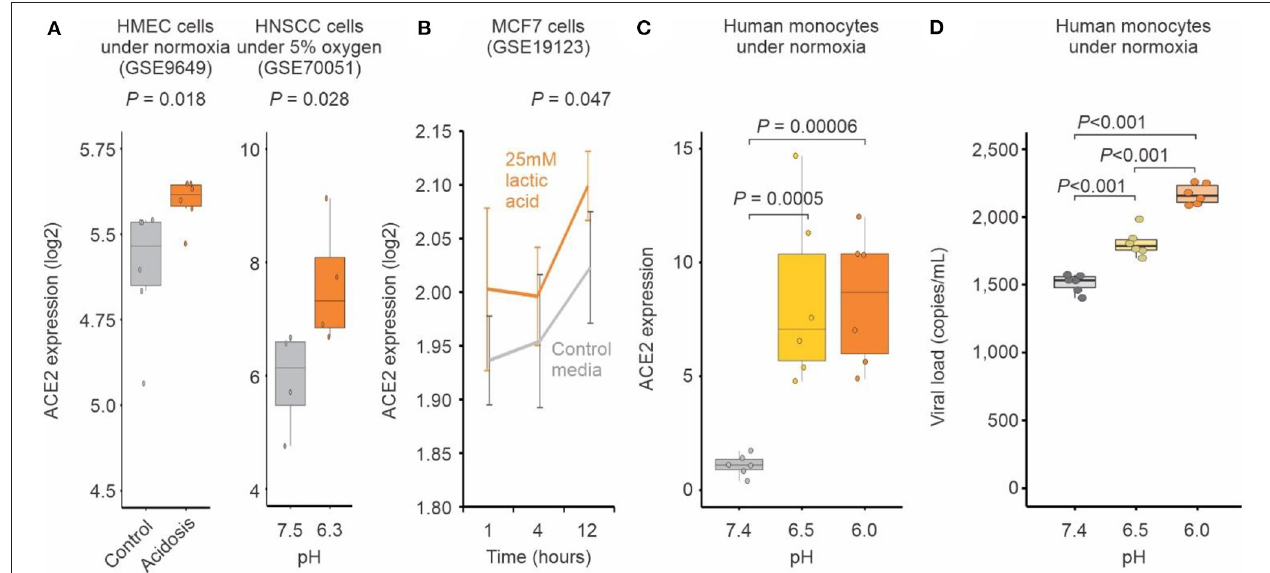
FIGURE 3 | Acidosis increases ACE2 expression and SARS-CoV-2 infection. (A) Human cells exposed to acidosis. Each boxplot represents the log2 expression of samples untreated (gray) or treated with lactic acidosis (brown) for two microarray studies (GSE9649 and GSE70051). Student’s t -test P -values are indicated. (B) MCF7 cells exposed to pH reduction increases ACE2 expression. Gray and brown lines represent, respectively cells treated with control media or with 25mM lactic acid for 1, 4, and 12h (x-axis). Each point represents the mean log2 expression and the error bars the standard deviation of biological replicates. (C) Acid pH increases ACE2 expression in monocytes. Human peripheral blood monocytes were incubated in medium at three different pH (6, 6.5, 7.4) for 24h. Each boxplot represents the fold change ACE2 expression. (D) Acid pH increases SARS-CoV-2 viral load. Human peripheral blood monocytes were incubated in medium at three different pH (6, 6.5, 7.4) for 24h. The cells were infected with CoV-2 (MOI 0.1) for 1h under continuous agitation. The RNA viral load was measured by qPCR.